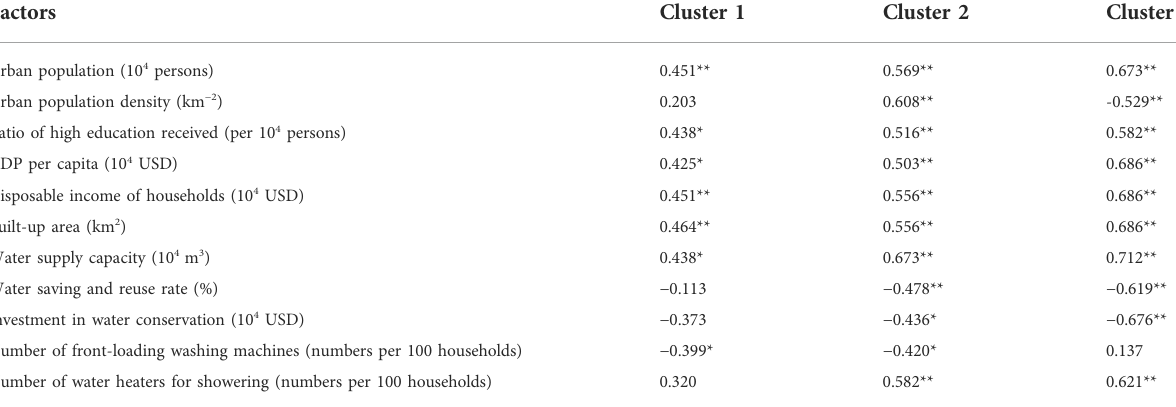
TABLE 1 Correlation coef fi cient between the liters per capita per day and in fl uencing factors in the three clusters. Factors Cluster 1 Cluster 2 Cluster